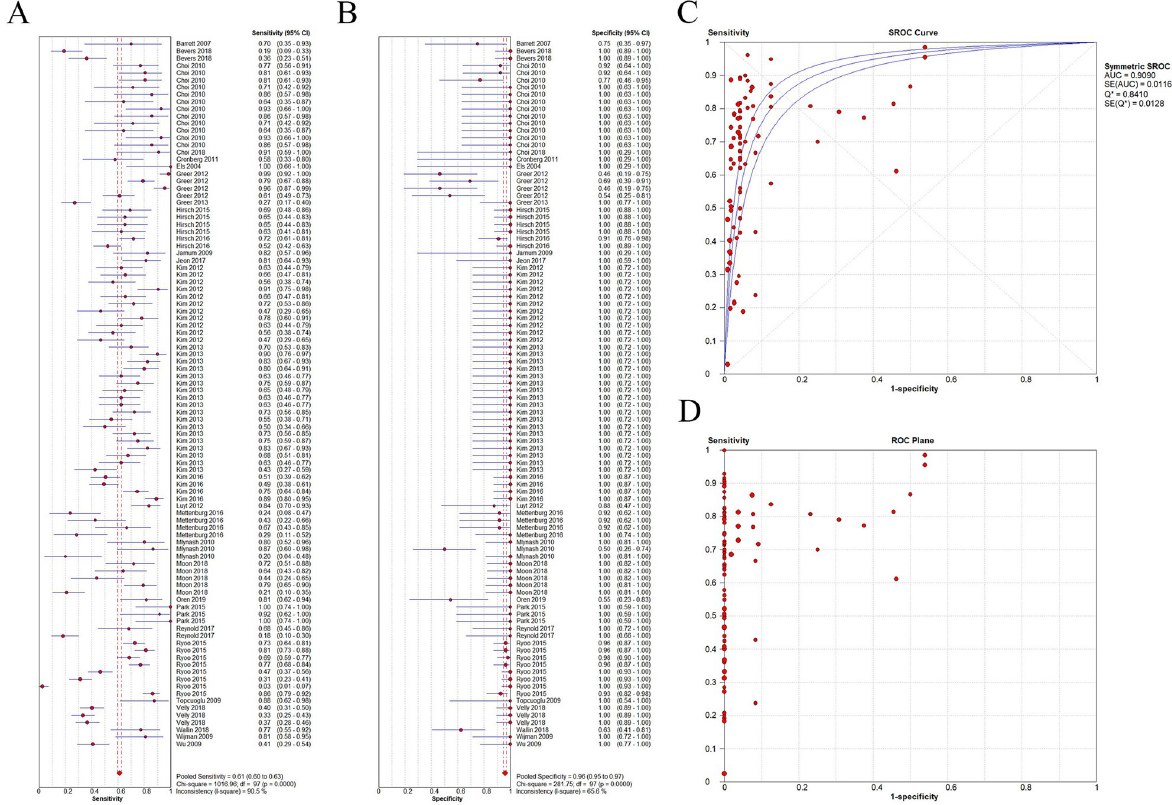
Fig 3. Diagnostic performance of the included studies. A,B: Forest plot demonstrating the sensitivity and specificity of individual studies arranged in alphabetical order. C Summary receiver operating characteristic (SROC) curve, D Receiver operating characteristic (ROC) plane respectively. CI: confidence